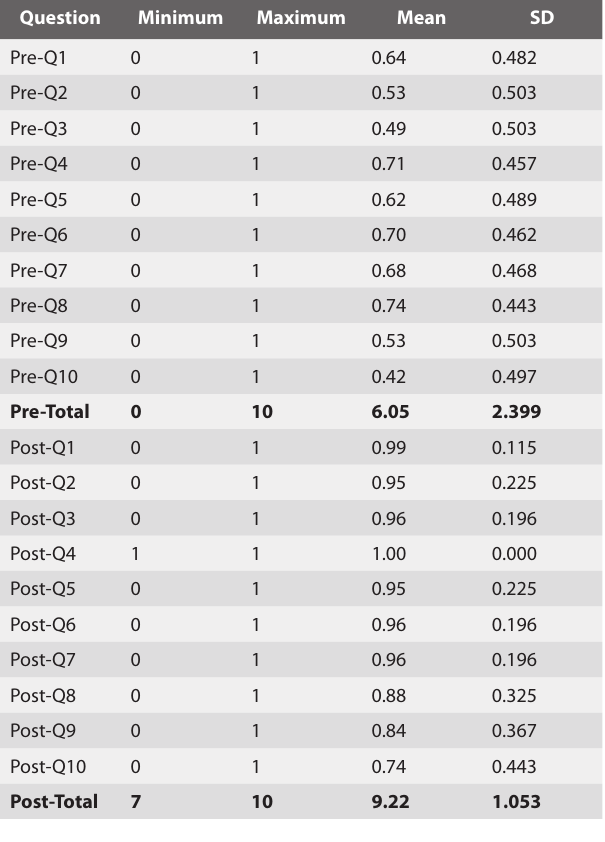
Table 1. The range, mean and standard deviation of pre and post scores of each question separately and total